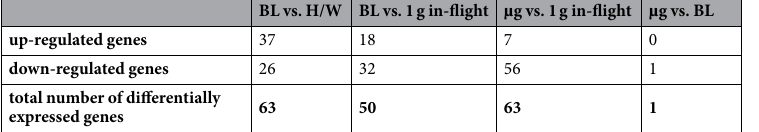
(Fig. 11a). After 75 s of hypergravity and 5 min of microgravity, subunit A of this enzyme remained up-regulated compared to the internal 1 g in-flight control. These data indicate that after up to 5 minutes of altered gravity, adaptation processes did not occur for this gene family. The second interesting gene that remained differentially expressed under altered gravity was the Long Intergenic Non-Protein Coding (LINC) RNA 837 (LINC00837). This regulatory RNA was down-regulated from 20 s up to 5 min of microgravity exposure (Fig. 11b). Thirdly, IGHD3-3 and IGHD3-10, belonging to the cluster of functional diversity (D) genes in the immunoglobulin (Ig) heavy chain locus on chromosome 14, remained differentially expressed in the inter-platform compari- son. IGHD3-10 was up-regulated after 20 s microgravity compared to the hypergravity parabolic flight samples. IGHD3-3 was down-regulated after 5 min of microgravity compared to the baseline control, representing the hypergravity phase in this experimental setup (Fig. 11c). Finally, we re-analyzed the RNA samples from both mission for the validation of gene expression data through a second independent analysis method, the quantitative real-time PCR. For the TEXUS-51 samples, quantita- tive real-time PCR analysis detected significant different gene expressions with values in the same magnitude as measured in the microarray analysis and therefore fully confirmed and validated the microarray data qualitatively